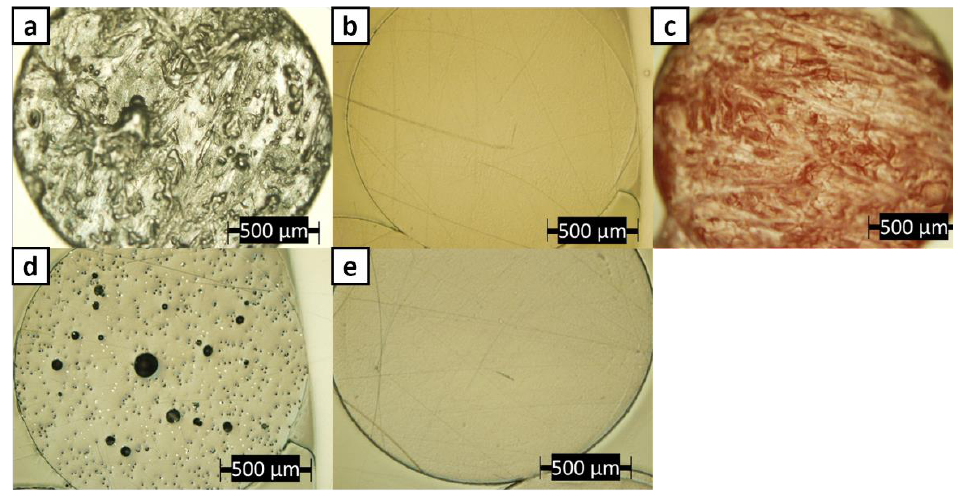
Figure 6. Optical images of cross-sections of ( a ) ABS w/CNT, ( b ) Lab-made ABS, ( c ) Premium ABS,